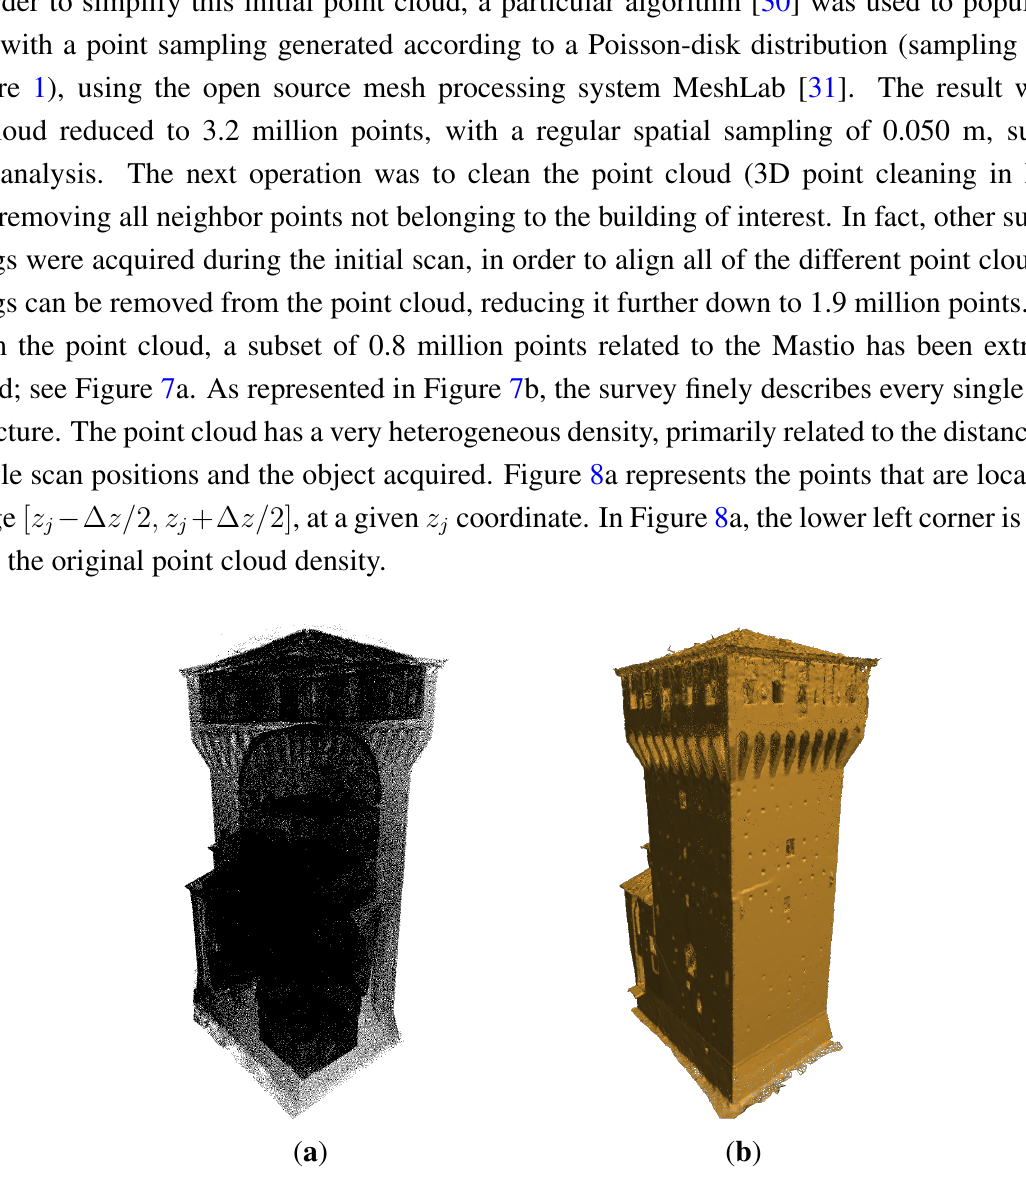
Figure 7. Three-dimensional models for Mastio tower. ( a ) Points; ( b ) triangular irregular network (TIN)